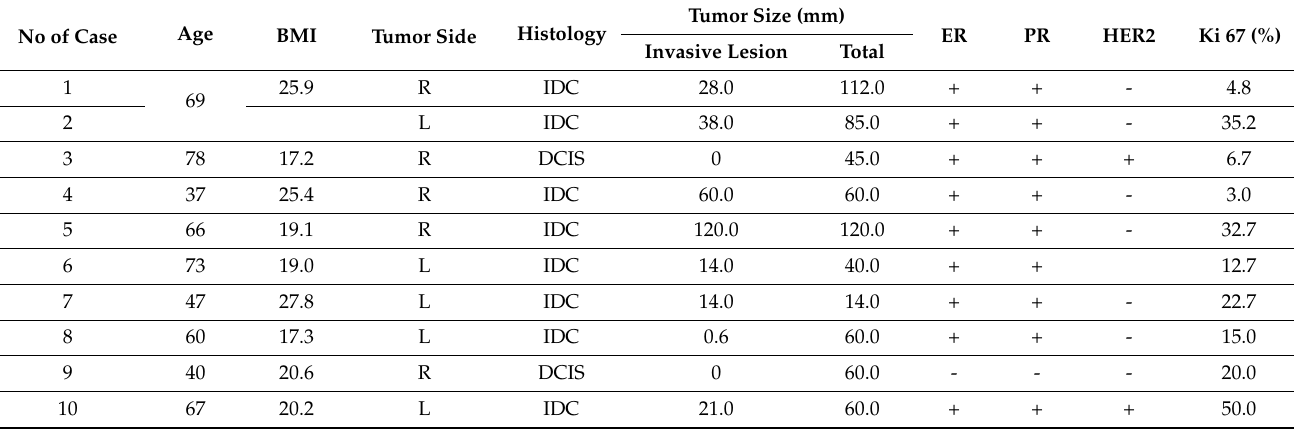
Table 1. Characteristics and pathological factors of the